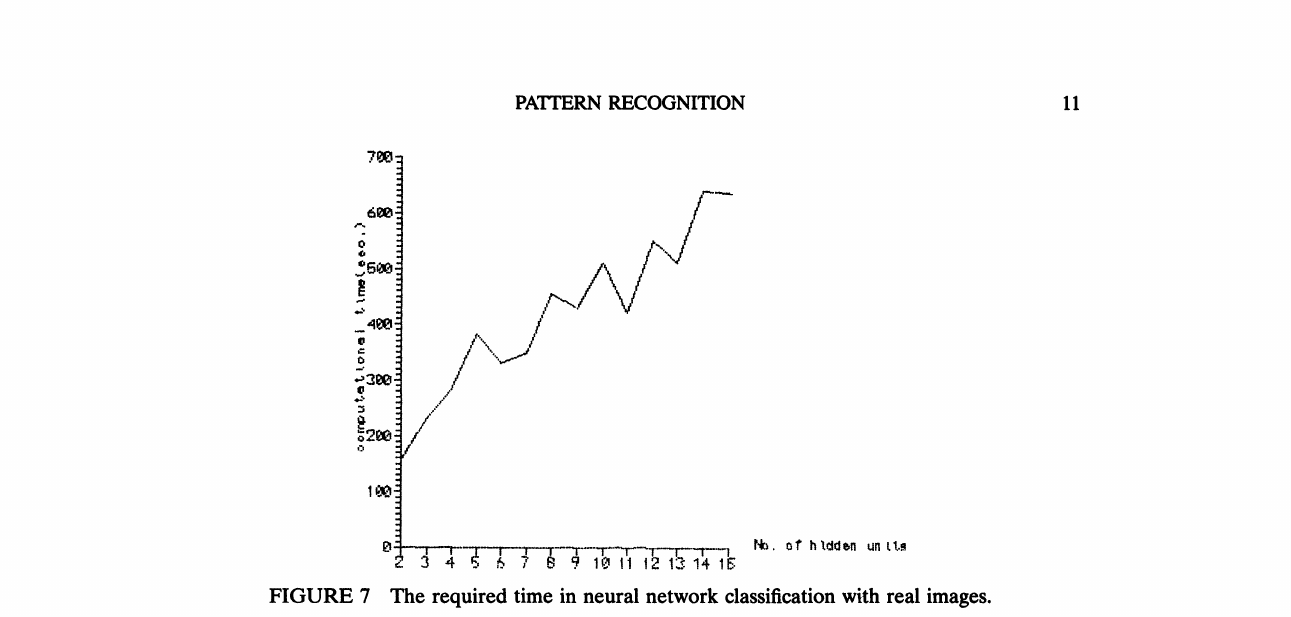
FIGURE 7 The required time in neural network classification with real